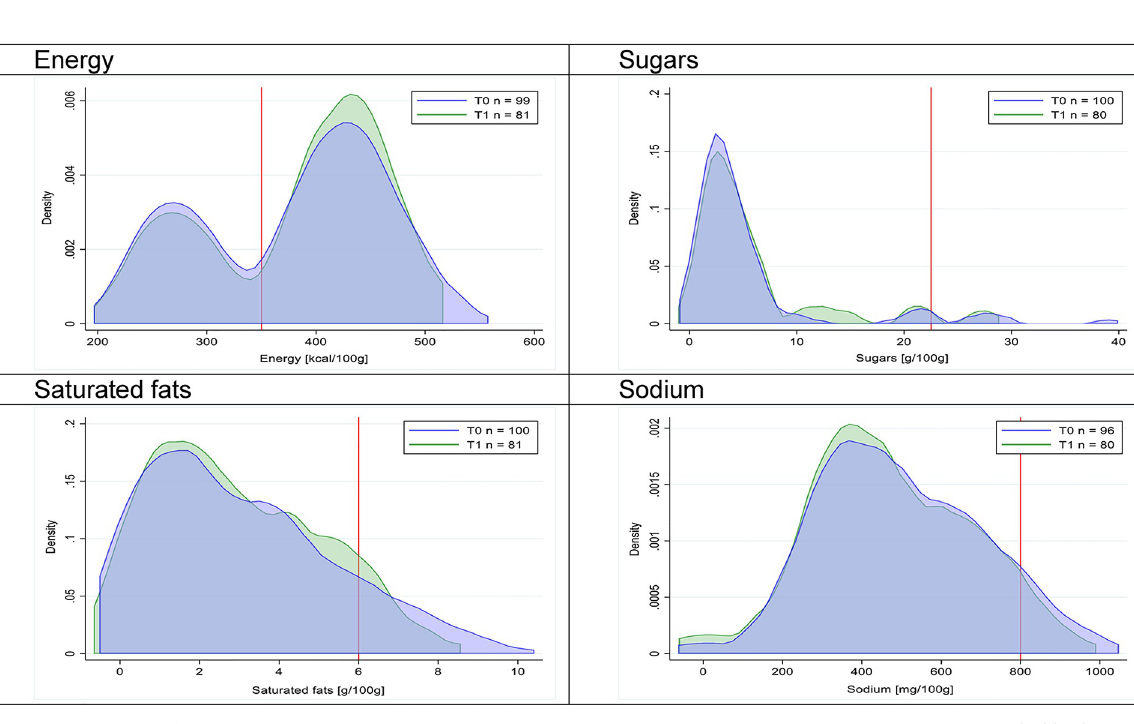
Fig 10. Density curves for the amount of energy and nutrients of concern in savory baked products, cross-sectional samples. The blue line represents the distribution in T0 (preimplementation), the green line represents the distribution in T1 (postimplementation), and the red line represents the cutoff for the amount of energy or nutrients of